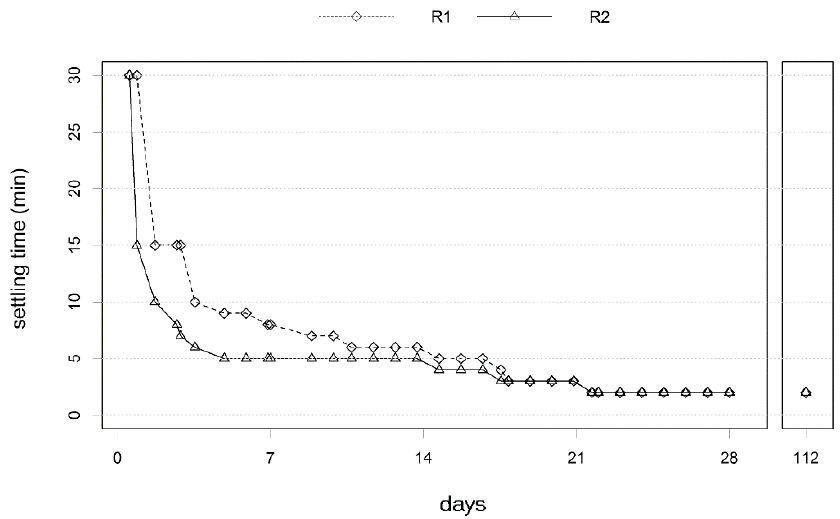
Figure 1. Settling time in reactor 1 (R1) and reactor 2 (R2). The settling time was decreased stepwise from 30 min to two min over the first 21 days of the experiment and maintained at two min until the end of the experiment.